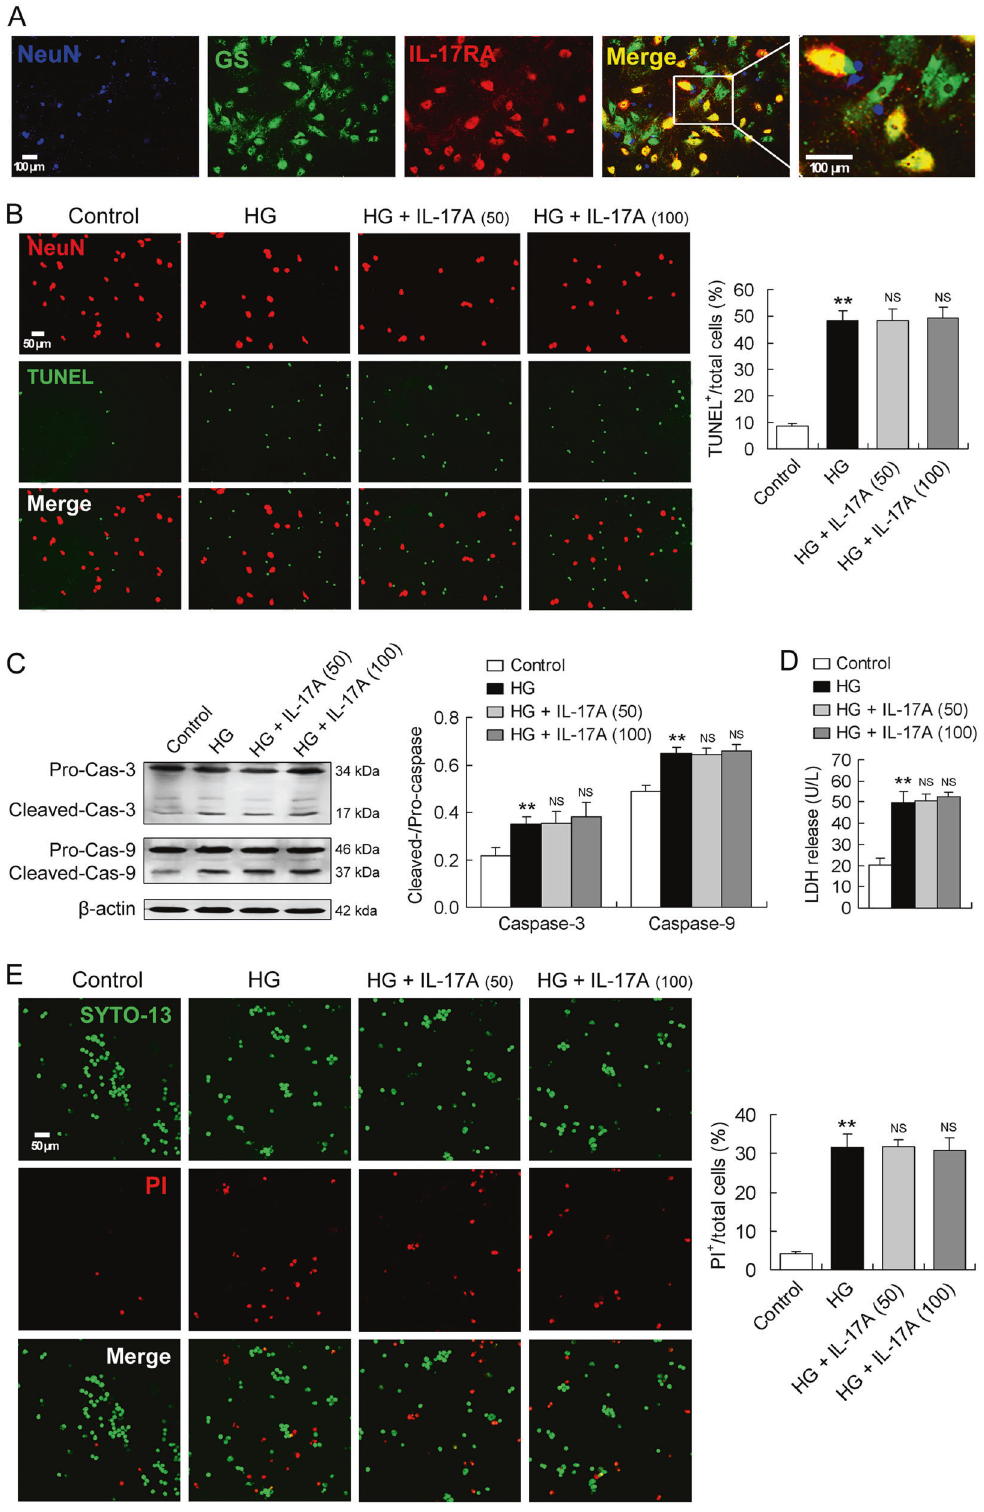
Fig. 5 RGCs do not express IL-17RA and IL-17A does not directly exacerbate HG-induced neuronal death. A Immuno fl uorescence images showing IL-17RA expression. Cocultures of RMCs and RGCs were stained with NeuN, GS, and IL-17RA to compare and identify the expression of IL-17RA in the two types of cells. As indicated in Fig. 4, GS and IL-17RA were co-localized. However, no co-localization of NeuN and IL-17RA was observed in the cocultures. B TUNEL assay showing RGC apoptosis. IL-17A was applied to primarily cultured RGCs at a concentration of 50 ng/ml (50) or 100 ng/ml (100) for 24 h in HG condition. C Caspase-3 and caspase-9 active levels determined by western blot analysis. D LDH release levels in RGCs. E SYTO-13/PI double staining showing RGC necrosis. Percentage of PI + dead cells in the sum of SYTO-13 + viable cells and PI + dead cells was registered for the statistics. All the data in the statistical histograms were obtained from fi ve independent experiments. ** P < 0.01, versus control; NS, no signi fi cance versus